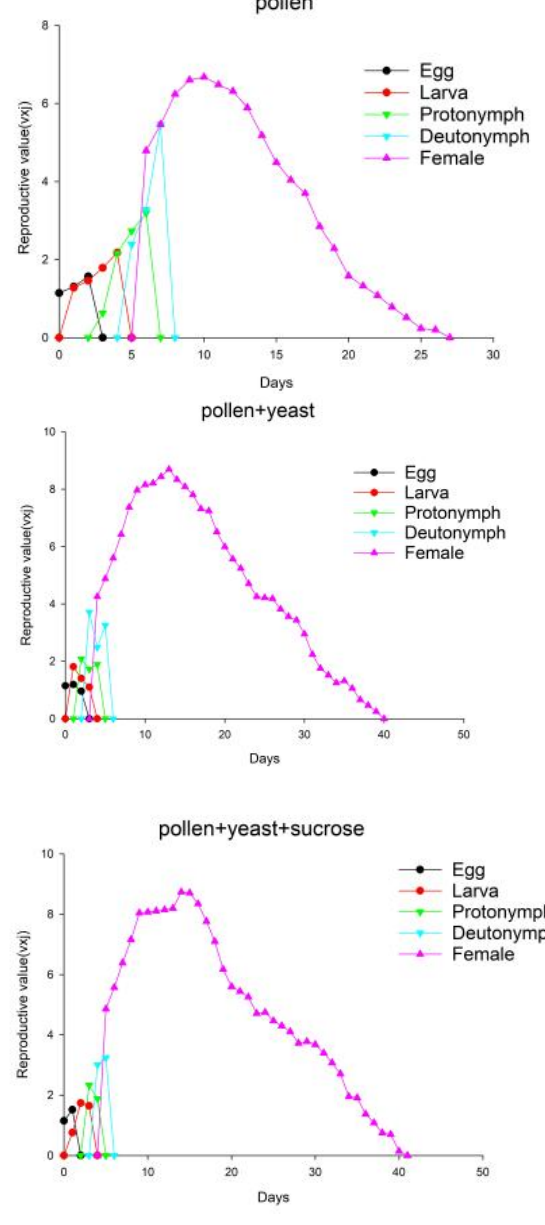
Figure 4. The reproductive value of Amblyseius orientalis individuals in the three treatment groups; v xj indicates the contribution of an individual of age x and stage j to the future growth of the population.